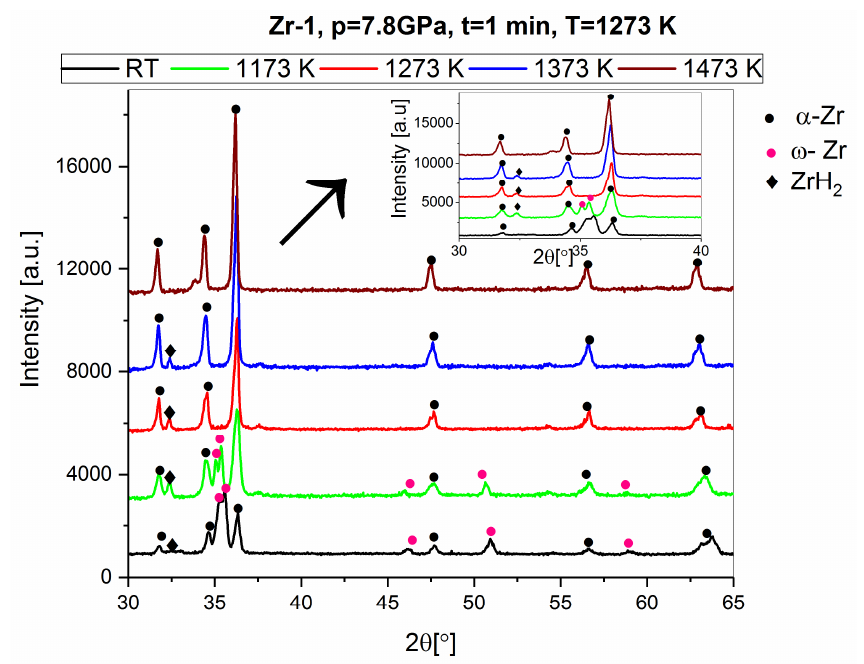
Figure 11. The X-Ray pattern for the heat treatment in the HTK2000 device of the Zr 1 high-pressure material sintered at 1273 K. Table 8. The qualitative and quantitative phase composition (wt. %) after heat treatment in the HTK2000 device of the Zr 1 material high-pressure sintered at 1273 K.